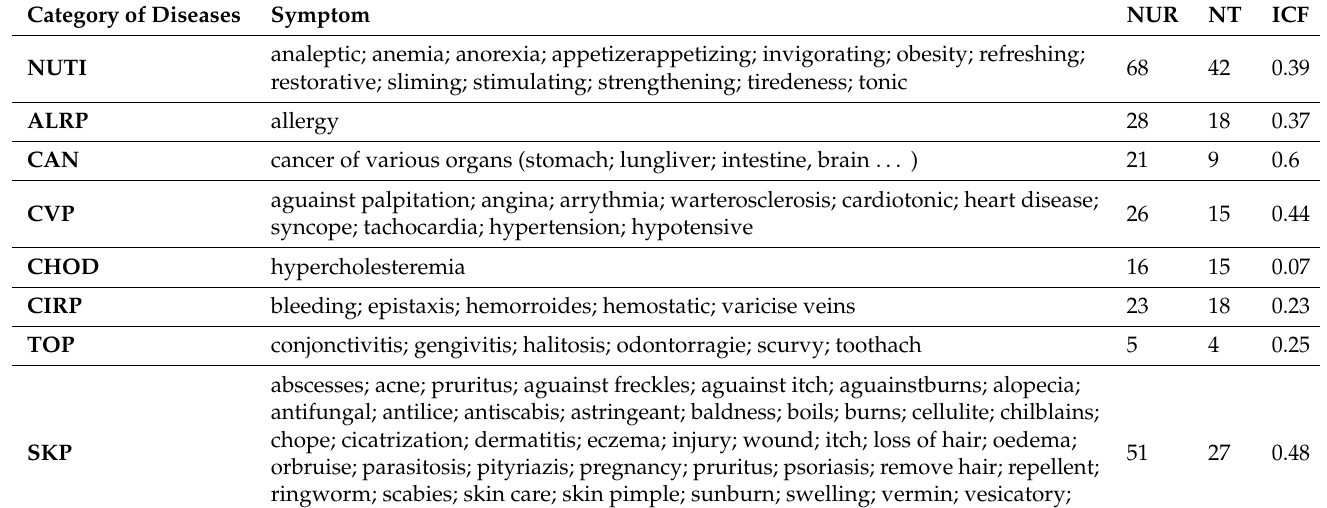
Table 5. Category of diseases, symptom, ICF, NUR (number of use citations in each ailment), NT (number of species used for this